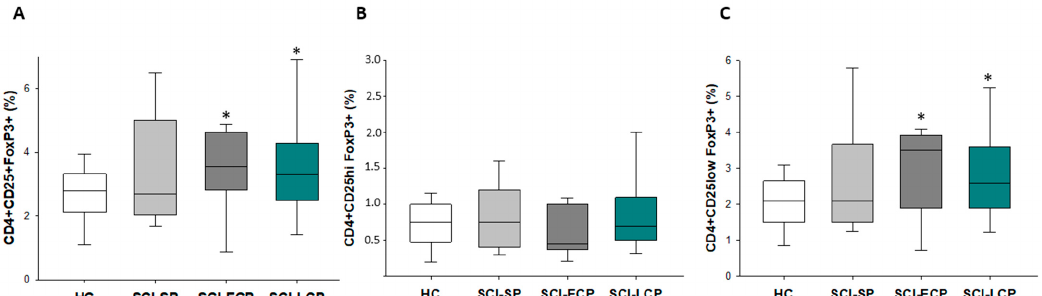
Figure 1. Characterization and percentage of circulating Treg cells according to the presence of specific markers: ( A ) CD4+ CD25+ Foxp3, ( B ) CD4+ CD25hi Foxp3 and ( C ) CD4+ CD25low Foxp3+ Tregs. Healthy controls (HCs); chronic SCI patients with a short period of evolution (1 – 5 years (SCI-SP)); chronic SCI patients in the early chronic phase (5 – 15 years (SCI-ECP)); and chronic SCI patients in the late chronic phase (>15 years-(SCI-LCP)). p < 0.05 (*).